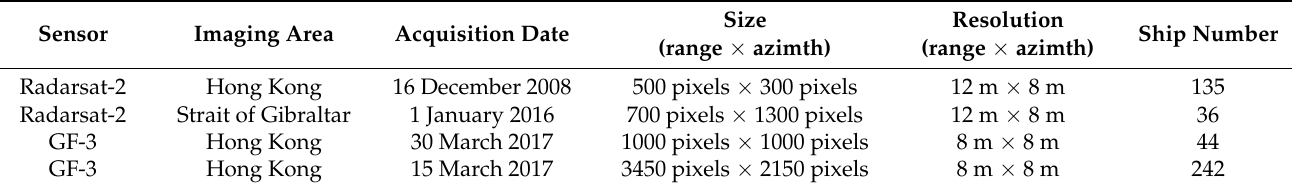
Table 1. Experimental data information.